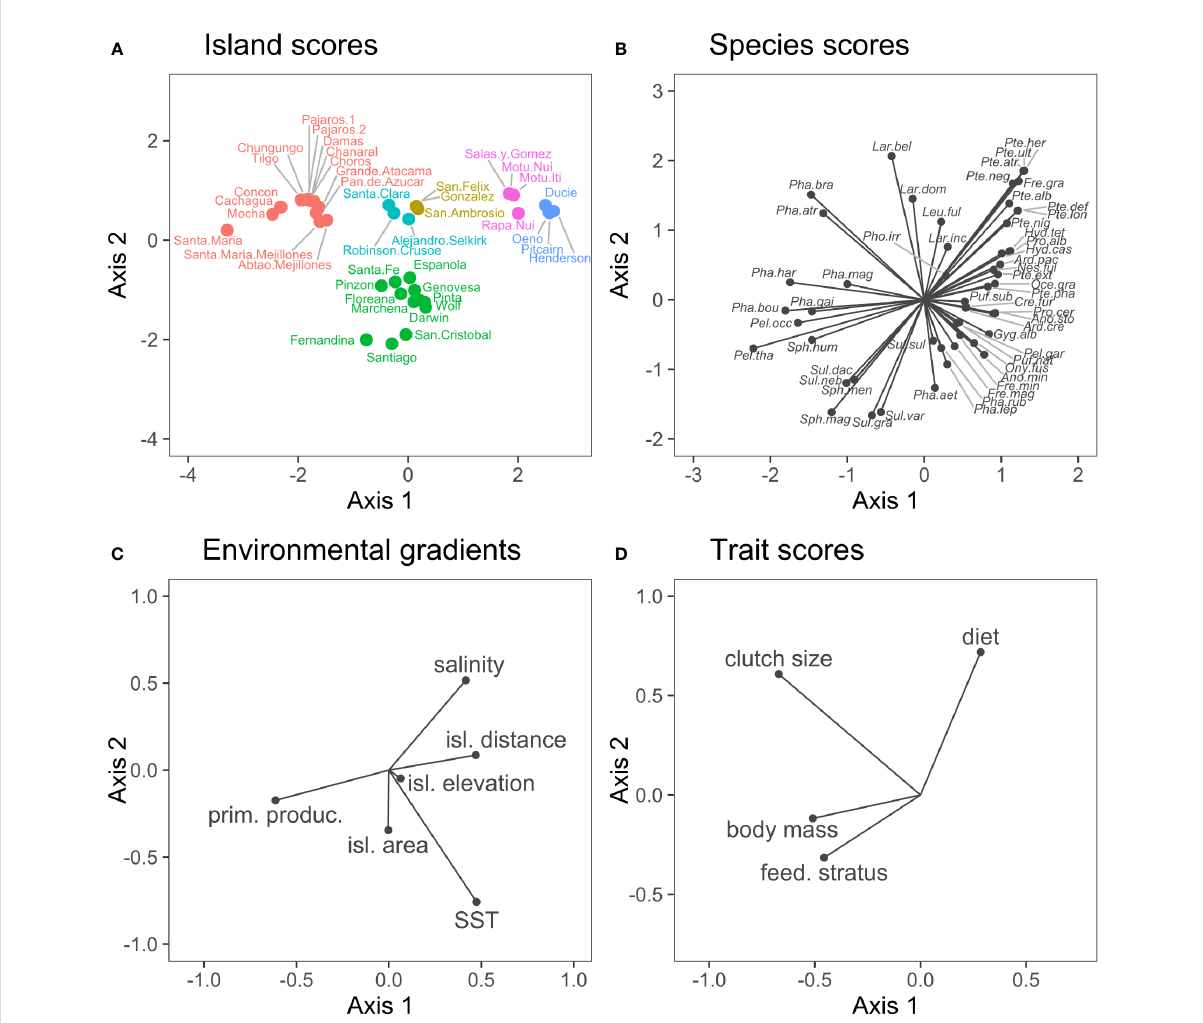
FIGURE 3 RLQ analysis showing the scores obtained after correspondence and principal component analysis (see Data analysis for details) for (A) islands, (B) species, (C) environmental variables, and (D) traits. Species abbreviations are de fi ned in Data sheet